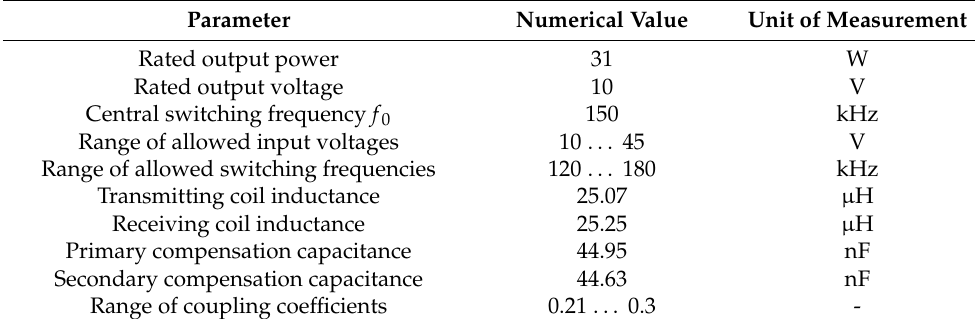
Table 1. The designed WPT system parameters